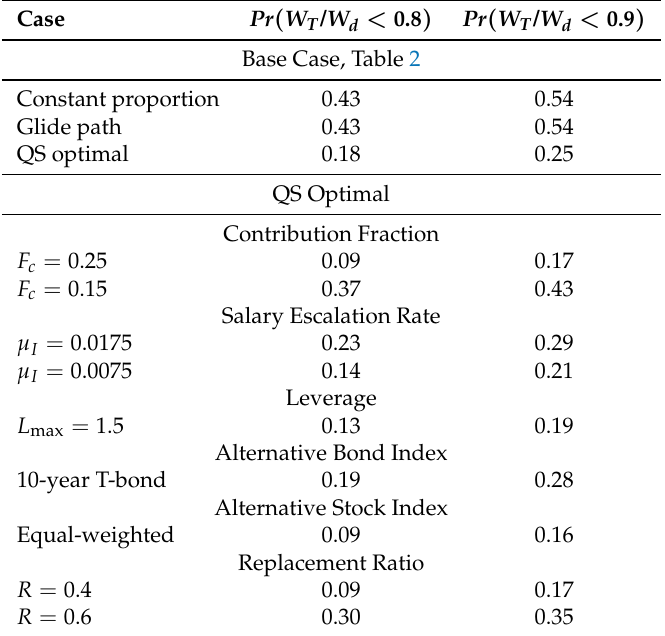
Table 11. Comparison of shortfall probabilities. Results are normalized by W d for each case. Input data provided in Tables 1 and 2, except as noted. Historical market results based on 10,000